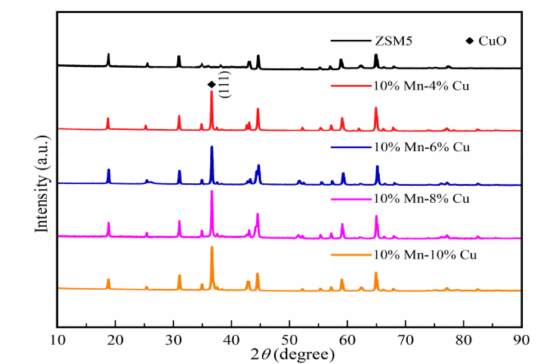
Figure 2. The XRD pattern of Mn-Cu / ZSM5 catalysts with di ff erent loadings of 4%, 6%, 8%, and 10% Cu,